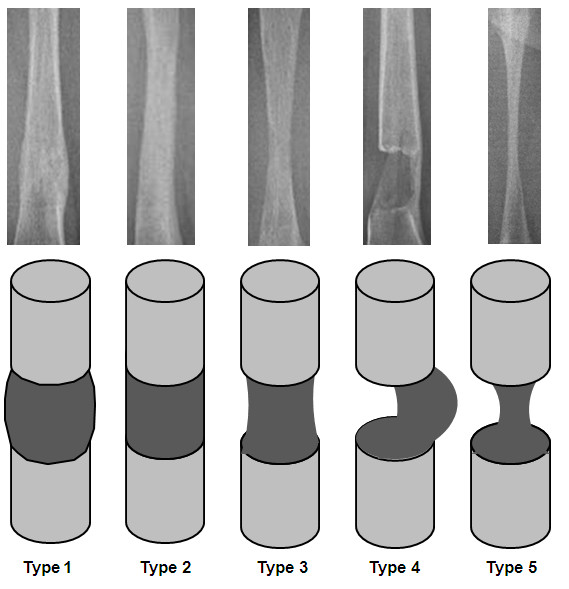
Radiographic appearance of the five types of callus shape in the Li classification [[12]: 1, fusiform; 2, cylindrical; 3, concave hourglass shape; 4, incomplete, only lateral; and 5, only central, filiform.